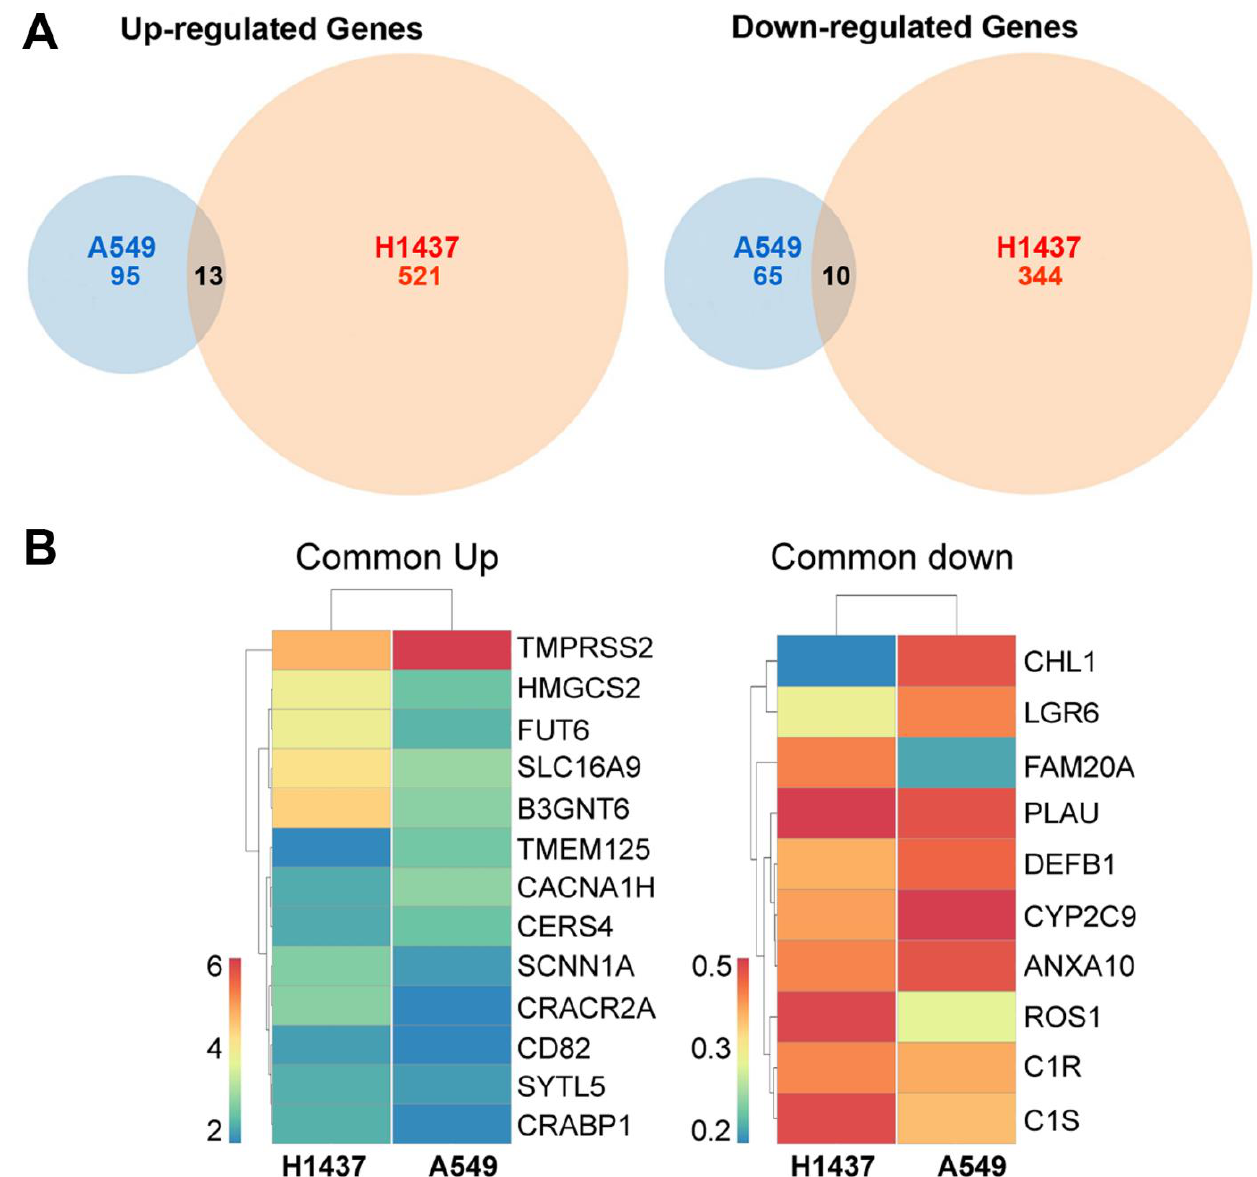
Figure 2. Gene expression profile by multiple RNA-seq experiments (three biological replicates per each cell line) followed by bioinformatics analysis of RelA/p65-compromised human tumours grown as xenografts in immune-compromised mice. ( A ) Following RNA-seq and bioinformatics comparative analysis, Venn diagrams were generated showing 13 genes in common up-regulated, and 10 genes in common down-regulated in both human A549 and H1437 NSCLC tumours; ( B ) heat maps of the common upregulated (left) and downregulated (right) genes in both cell lines that were increased or decreased by at least 2-fold in the tumour xenografts of the RelA/p65 KD human A549 and H1437 NSCLC tumours compared to their vector control counterparts.